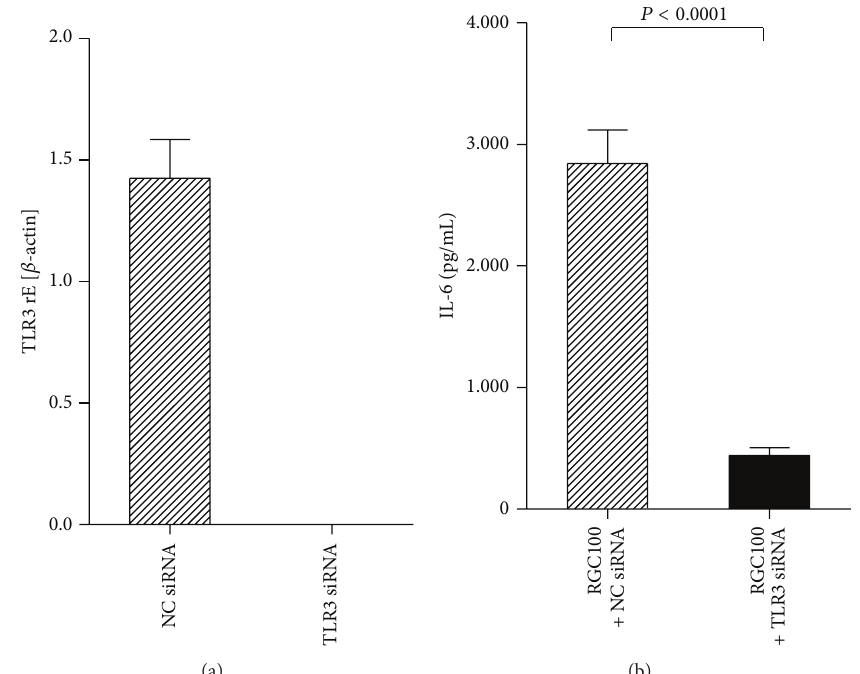
Figure 4: Inhibition of activation of JAWS II DCs by RGC100 using siRNA targeting TLR3. Cells were treated with siRNA targeting TLR3, then incubated with RGC100 at the indicated concentrations. RNA was extracted and supernatant was harvested. (a) Relative expression of TLR3 mRNA in cells treated with siRNA targeting TLR3 or with a nontargeting siRNA (NC siRNA). mRNA levels were normalized to 𝛽 -actin mRNA. rE, relative expression. (b) Secretion of IL-6 was measured by ELISA. Values shown are mean ± SEM of two independent measures. Negative control consists of supernatant of cells incubated in the absence of RGC100 and siRNA. Values of negative control have been subtracted from the values represented on the graph. Table 1: Comparison of the physicochemical and functional properties of RGC100 and poly(I:C). Length Molecular weight Chemical structure Biostability a Agonist